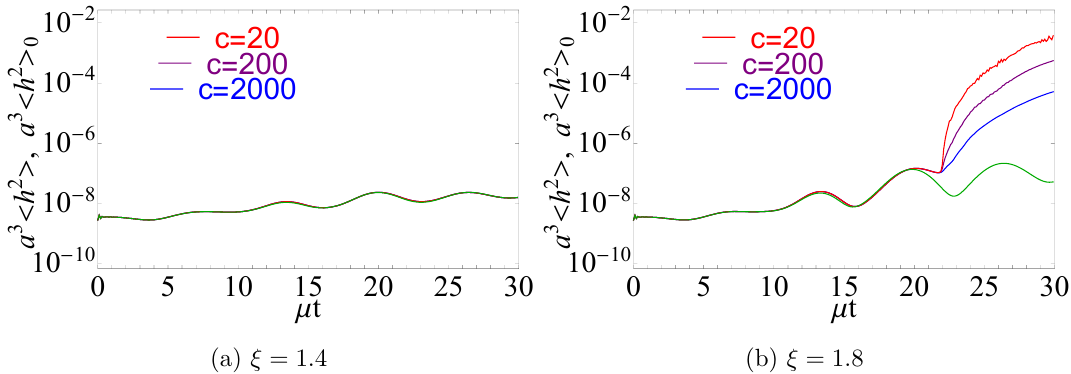
Figure 4. Lattice simulation results of the Higgs field variance h h 2 i for ξ = 1 . 4 and 1 . 8 and varying values of c : 20 (red), 200 (purple) and 2000 (blue). The top quark mass is taken to be M t = 172 GeV, and the strong coupling is the central value α s = 0 . 1179 . Time evolution of h h 2 i 0 is shown in green line. Both h h 2 i and h h 2 i 0 are multiplied by a 3 and normalized by M 2 Pl